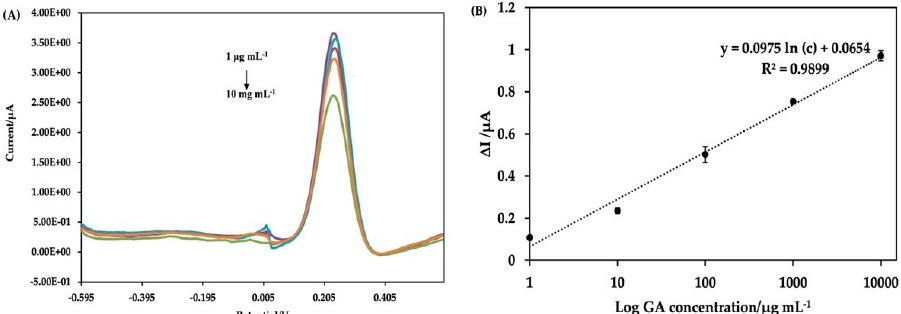
Figure 5. ( A ) SWV response of aptamer/GO/SPCEs aptasensor after incubation with 1 µg mL − 1 (purple), 10 µg mL − 1 (blue), 100 µg mL − 1 (red), 1 × 10 3 µg mL − 1 (orange), and 1 × 10 4 µg mL − 1 (green) of GA ; ( B ) Calibration plot of the aptasensor showing the linear relationship between the logarithm of GA concentration 1–1 × 10 4 µg mL − 1 and corresponding maximum current ( ∆ I) from SWV. Mean current value of each concentration was plotted from three independent experiments. Table 1. Comparison of LOD from different biosensors for detection of glycated albumin. No.